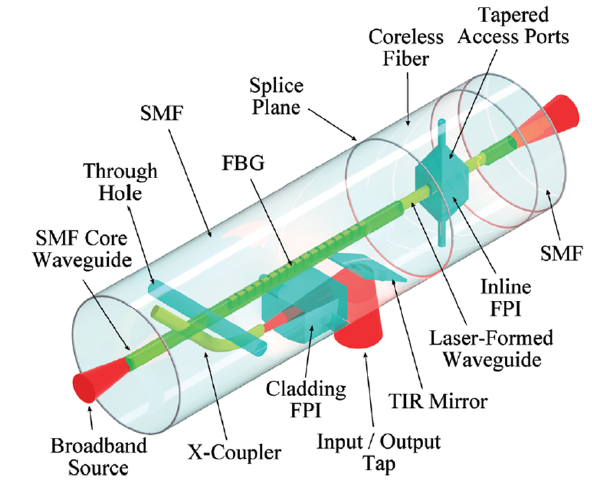
Figure 12: Lab-in-fibre concept, combining 3D waveguides with mi- crofluidics within a 125 µ m diameter optical fibre to create compact sensors. The through hole can be used for fluorescence detection and absorption spectroscopy. The fibre Bragg grating enables tem- perature and strain measurements. The Fabry-Perot interferometers (FPI) facilitate refractive index and pressure sensing, and the to- tal internal reflection (TIR) 45 ∘ mirror acts as light tap or cladding mode stripper. With permission from [197]. Copyright 2014 The Royal Society of